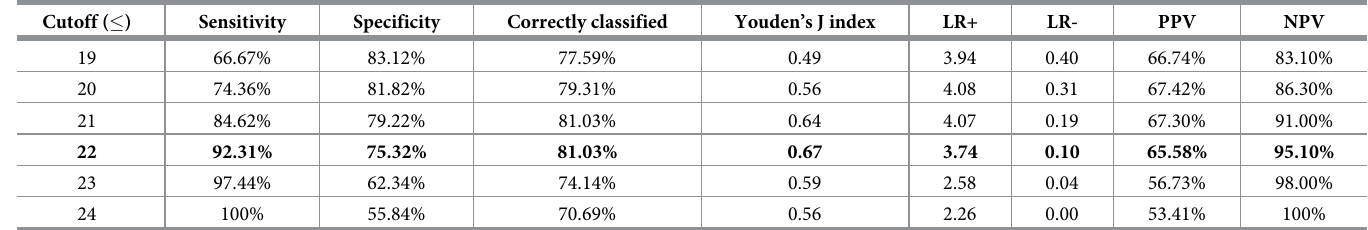
Table 2. Psychometric properties of RUDAS for the diagnosis of major neurocognitive disorder, 2020. Cutoff ( � )